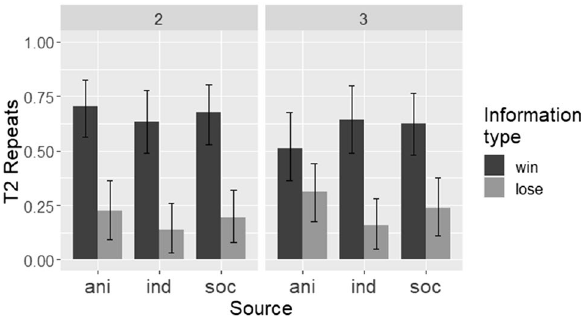
Figure 3. Children’s task performance (as measured by T2 repeats), by source, information type, and array size. Bars show means of by-participant means, and error bars show bootstrapped 95% confidence intervals. ani animated cue, ind individual, soc social.